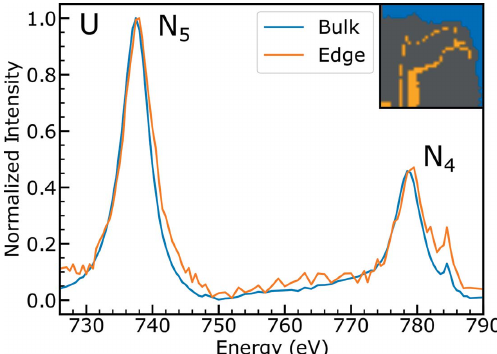
Figure 9 Uranium spectra on sample 2B (same location as Fig. 6). The inset shows the two regions the averaged spectra were taken from. The interfacial spectrum has peaks slightly higher in energy, as expected for a higher oxidation state of uranium.